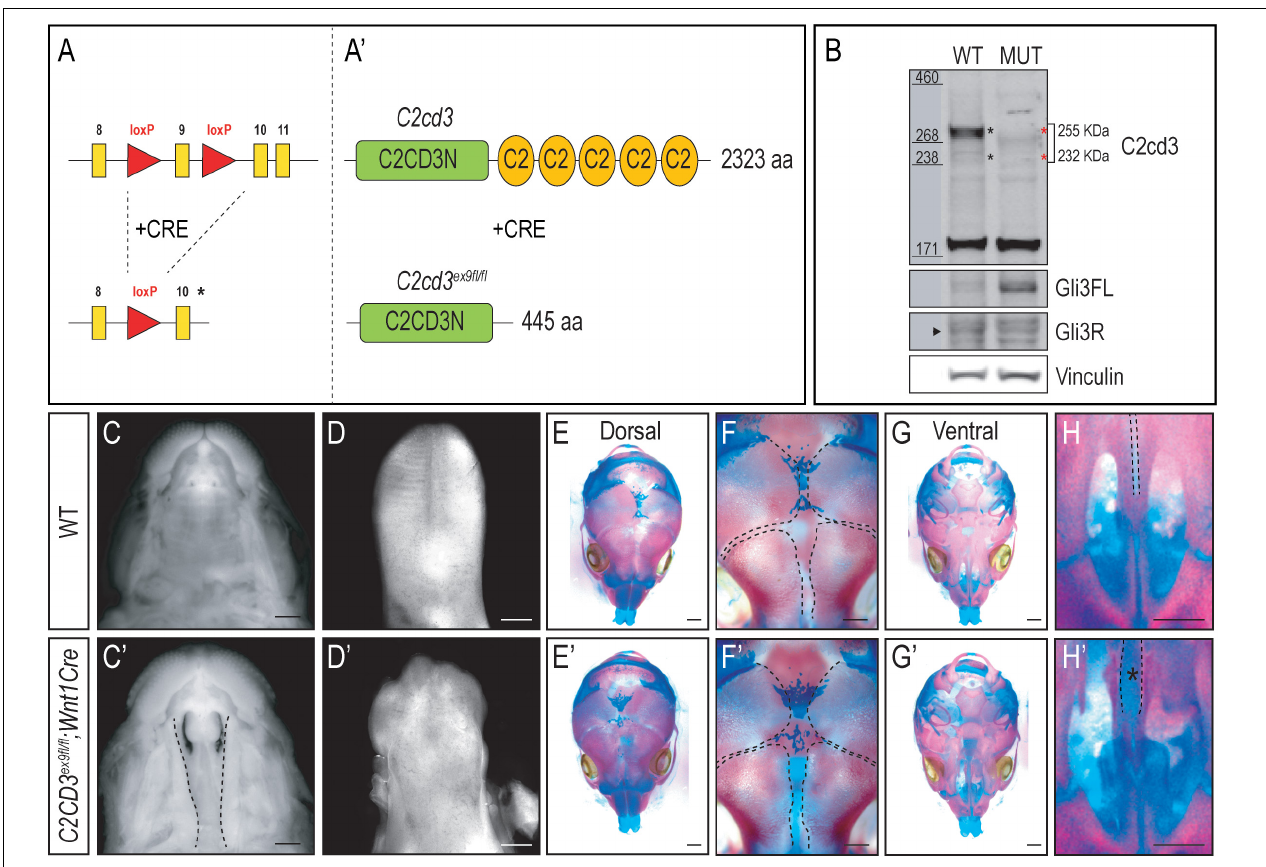
FIGURE 3 | Conditional loss of PKC-C2 domains of C2cd3 results in craniofacial phenotypes. (A,A (cid:48) ) Schematic of conditional mouse line generated by CRISPR-targeting with LoxP sequences flanking exon 9. (B) Western blot of C2cd3 expression in E11.5 facial prominences showing deletion of the 255 and 232 kDa isoforms in and C2cd3 ex9fl / fl ;Wnt1-Cre embryos (red asterisks, n = 4 for both wild type and mutant, not shown). (C,C (cid:48) ) Palatal and (D,D (cid:48) ) glossal views of wild-type and C2cd3 ex9fl / fl ;Wnt1-Cre E15.5 embryos. Cleft palate [ (C (cid:48) ) , dotted lines] and dysmorphic tongue are present in C2cd3 ex9fl / fl ;Wnt1-Cre embryos. (E–H (cid:48) ) Dorsal and ventral views of whole mount skeletal staining reveals delayed ossification of palatine bone in C2cd3 ex9fl / fl ;Wnt1-Cre embryos [ (H,H (cid:48) ) , asterisk]. Scale bars: 0.5